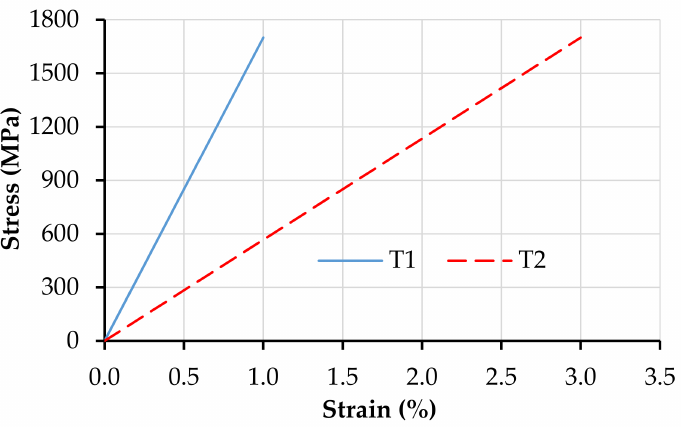
Figure 3. Tensile constitutive laws of the continuous reinforcement under